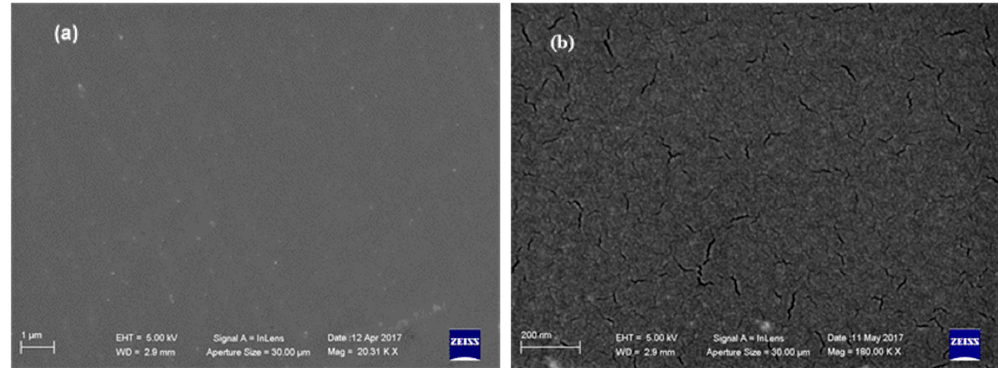
Figure 10. SEM microphotographs of BIOPU_25 at different magnifications: ( a ) 20 Kx; ( b ) 180 Kx. This different morphology can be due to the foaming process caused by atmosphere moisture at the bond surface of polyurethane. This phenomenon, known also as “surface crazing”, produces deep cracks and splits through the polymer, with the depth of cracking increasing with greater extension [35]. mixture, and particularly with those of the starting polyol. Therefore, it is expected that the more